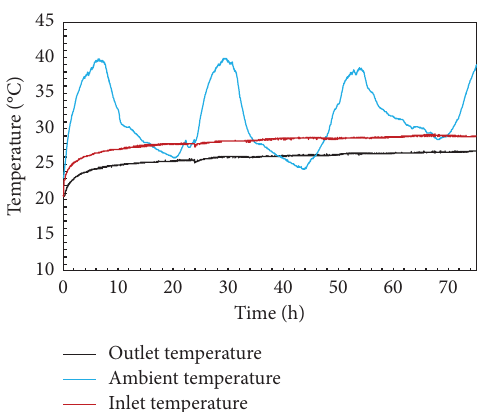
Figure 2: Recorded ambient, inlet, and outlet temperatures.